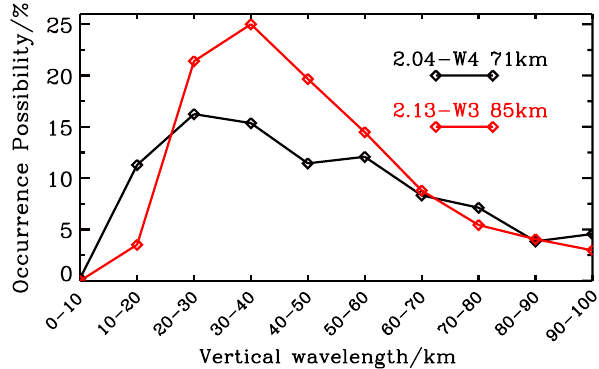
Fig. 11. Distributions of occurrence possibilities of vertical wave- lengths of (2.13, W3) (red line) and (2.04, W4) (black line) in alti- tudes of their peak